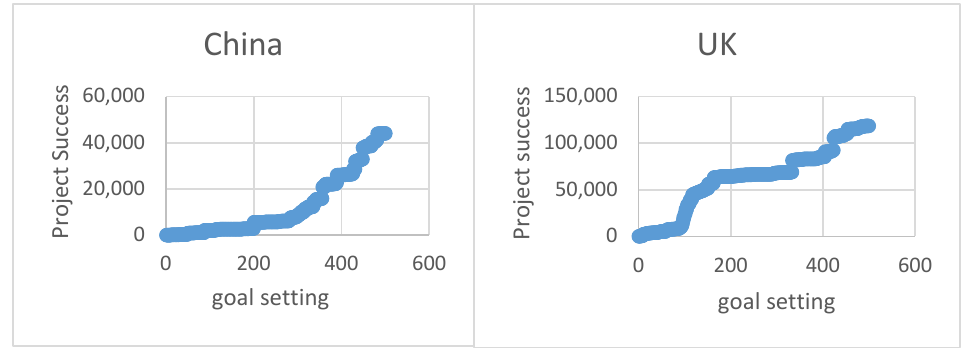
Figure 2. The effect of higher goal setting on project success in China and UK after robustness. Figure 2. The e ff ect of higher goal setting on project success in China and UK after